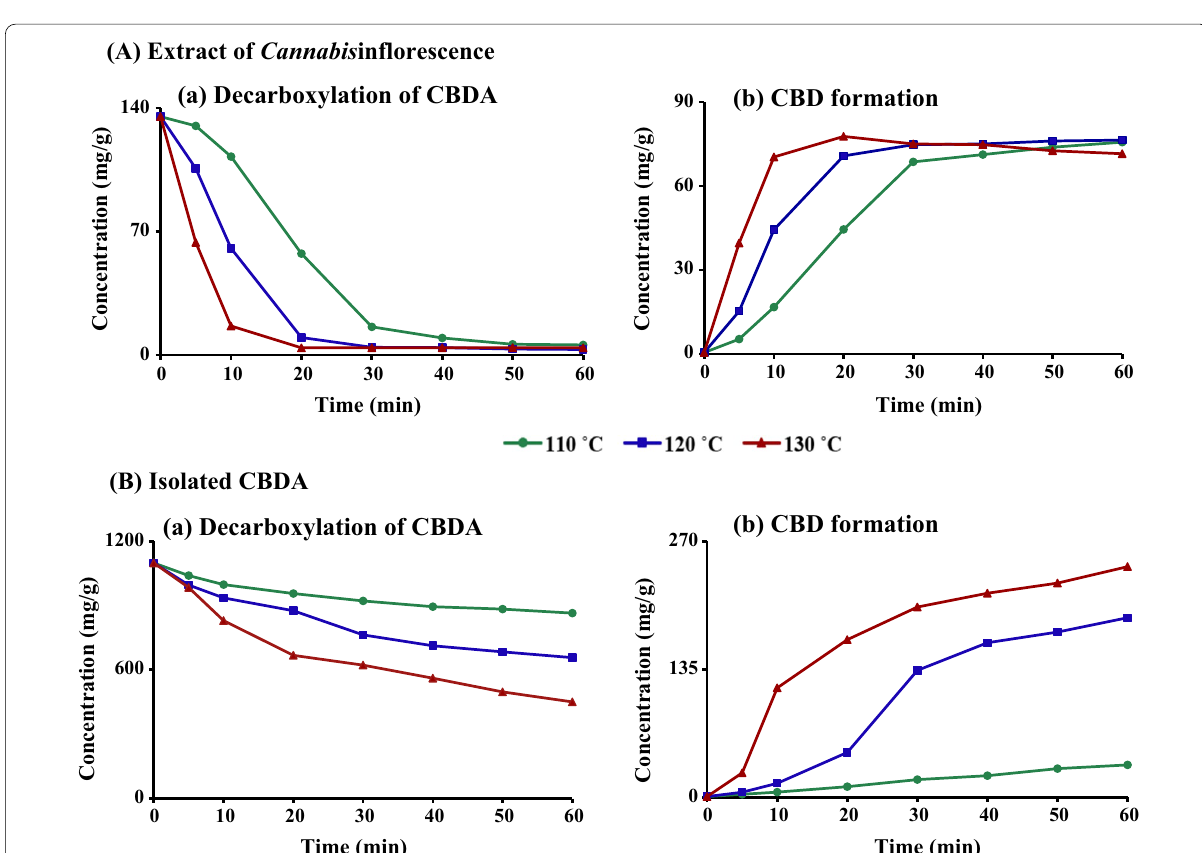
Fig. 5 Time profile of CBDA decarboxylation and CBD formation for A Cannabis extract and B isolated CBDA according to different